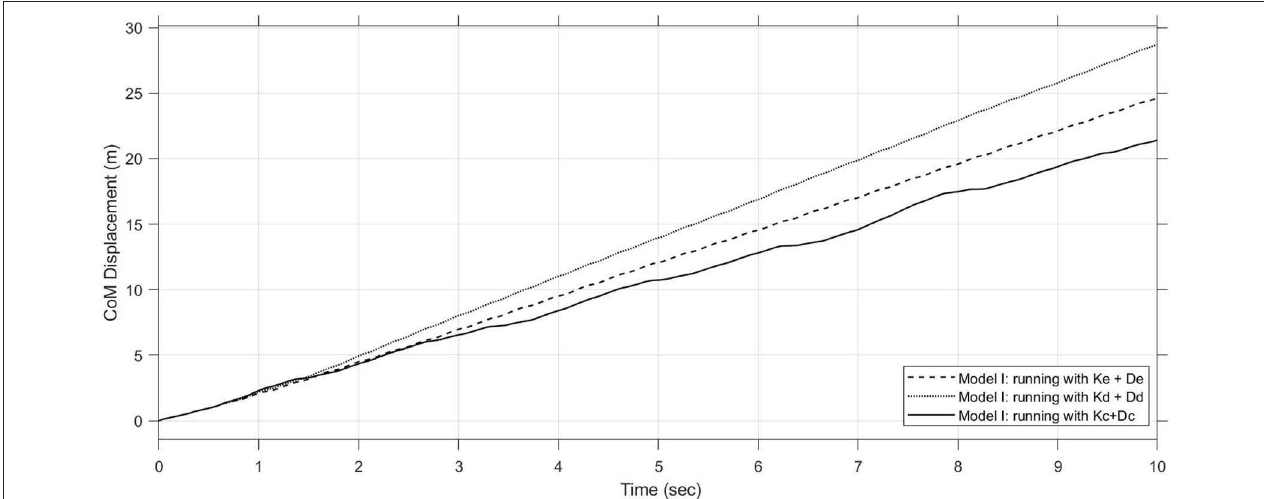
D c , K d D d , and K e D e + + +